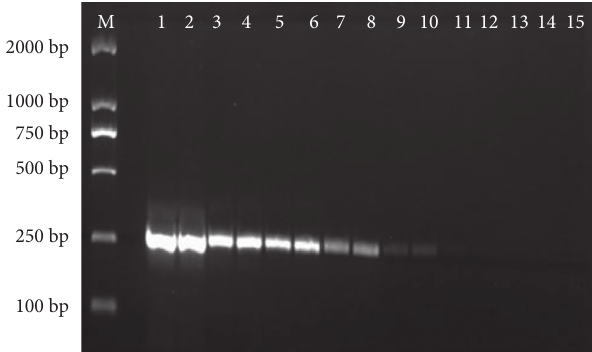
Figure 3: Sensitivity analysis of primers for 16S–23S. M , DNA marker D (100–2000bp); lanes 1-2, 40ng (10 0 ); lanes 3-4, 4ng (10 − 1 ); lanes 5-6, 0.4ng (10 − 2 ); lanes 7-8, 0.04ng (10 − 3 ); lanes 9-10, 0.004ng (10 − 4 ); lanes 11-12, 0.0004ng (10 − 5 ); lanes 13-14, 0.00004ng (10 − 6 ); and lane 15, blank control. Table 2: Statistical analysis of homogeneity detection of genomic DNA reference material of C. sakazakii